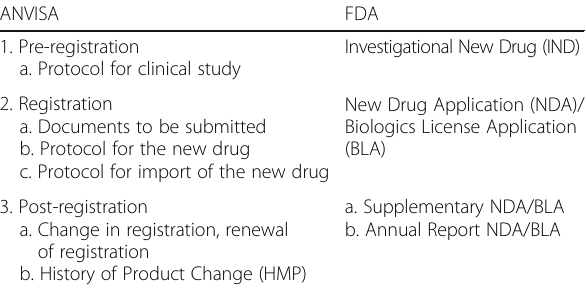
Table 2 Registration process of ANVISA vs. FDA